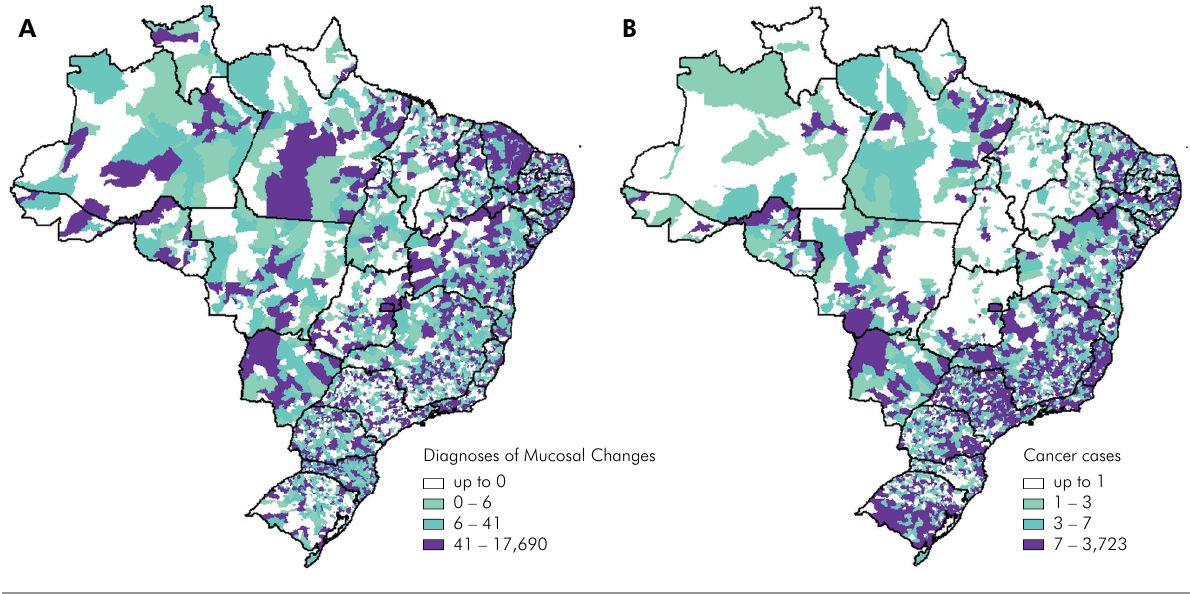
Figure 1. A: Frequency distribution into quartiles of diagnoses of mucosal changes among Brazilian cities. B: Frequency distribution into quartiles of hospitalized patients with oral and oropharyngeal cancer among Brazilian cities.